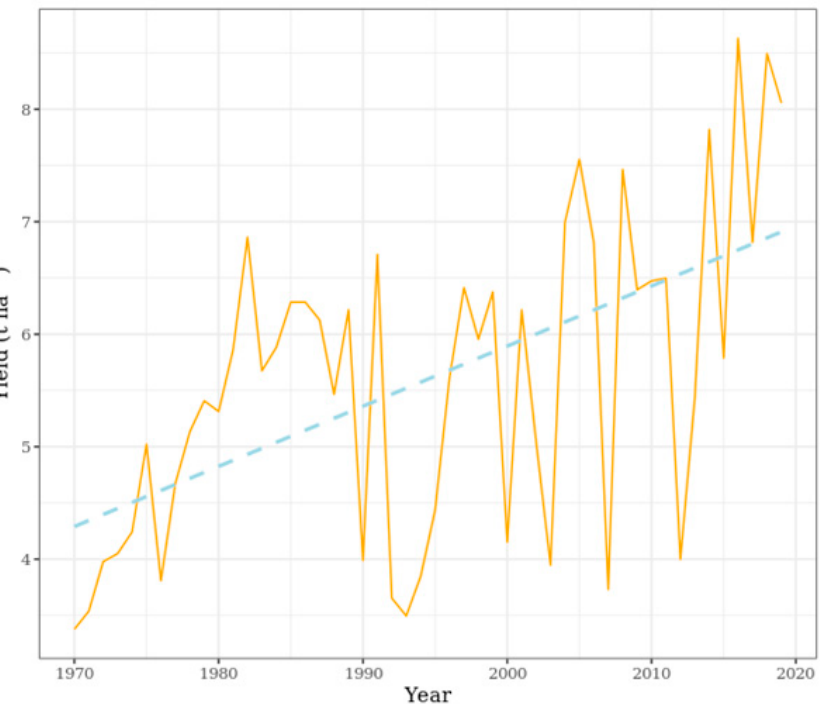
Figure 3. Average yields of maize in Hungary (1970–2019).